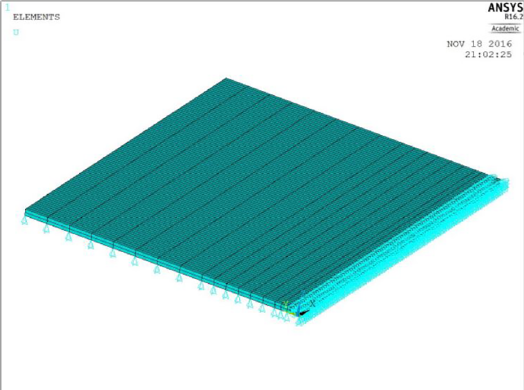
Figure 7. Three dimensional finite element